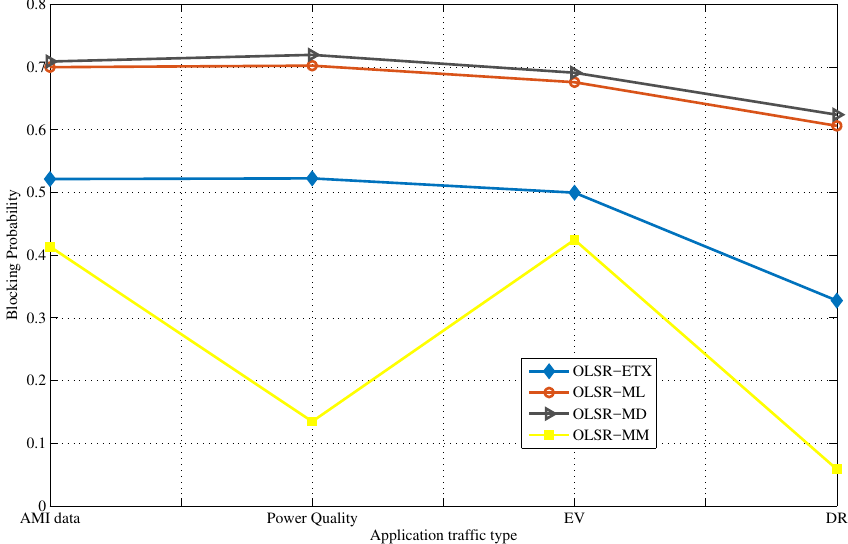
Figure 10. Blocking probability for all application traffic types.